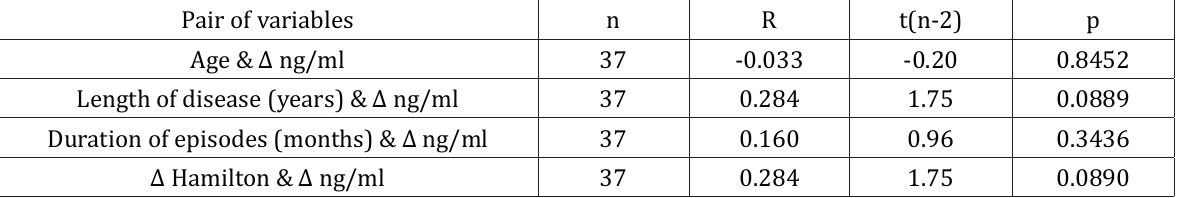
The following correlations were determined for differences in the concentration of MMP-9 between the start and end points. Table 10. The results of the Spearman rank correlation coefficients between age, duration of the disease, duration of episodes, differences in the severity of depression symptoms according to the HDRS, and differences in the concentration of MMP-9 between the initial and end point tests